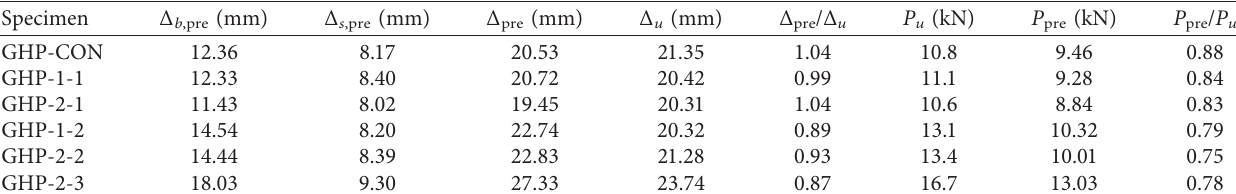
Table 4: Summary of the midspan deflection and ultimate bending strength of GHP specimens.